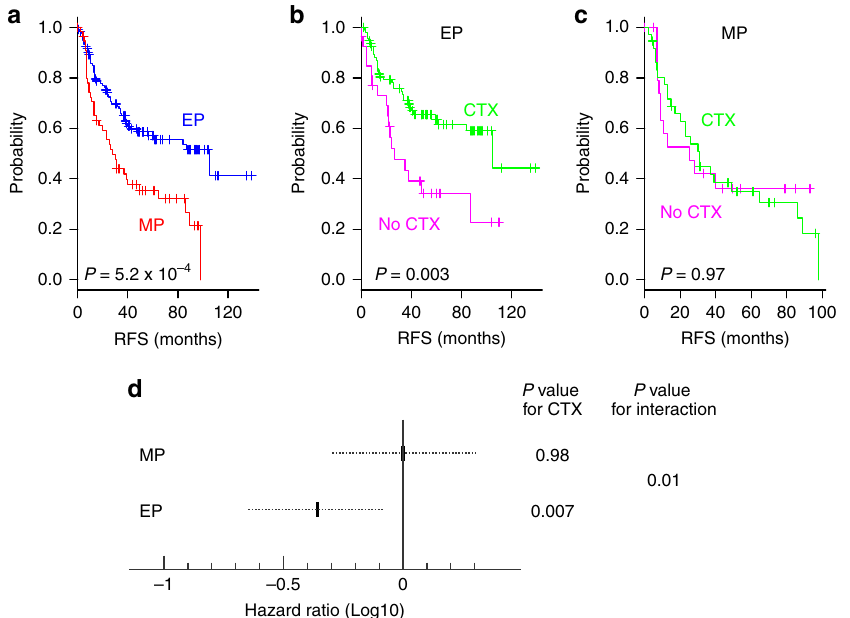
Fig. 4 Clinical signi fi cance of MP subtype. a – c Kaplan – Meier plots of recurrence-free survival (RFS) in patients with American Joint Committee on Cancer (AJCC) stage II, III, or IV disease without distant metastasis. Analysis was performed for this subset of patients pooled from three cohorts (Korea University Guro Hospital, Yonsei University Severance Hospital, and Kosin University College of Medicine cohorts; n = 180). a Kaplan – Meier plots of RFS among patients with each subtype of gastric cancer (EP epithelial subtype, MP mesenchymal subtype). b , c Kaplan – Meier plots of RFS among patients who received adjuvant chemotherapy (CTX) and those who did not (No CTX) for each tumor subtype. P values were obtained using the log-rank test. d Interaction of tumor subtype with adjuvant chemotherapy in patients with gastric cancer. The Cox proportional hazards regression model was used to analyze the interaction between tumor subtype and adjuvant chemotherapy (CTX). The dotted lines represent the 95% con fi dence intervals of the hazard ratios. EP epithelial phenotype, MP mesenchymal